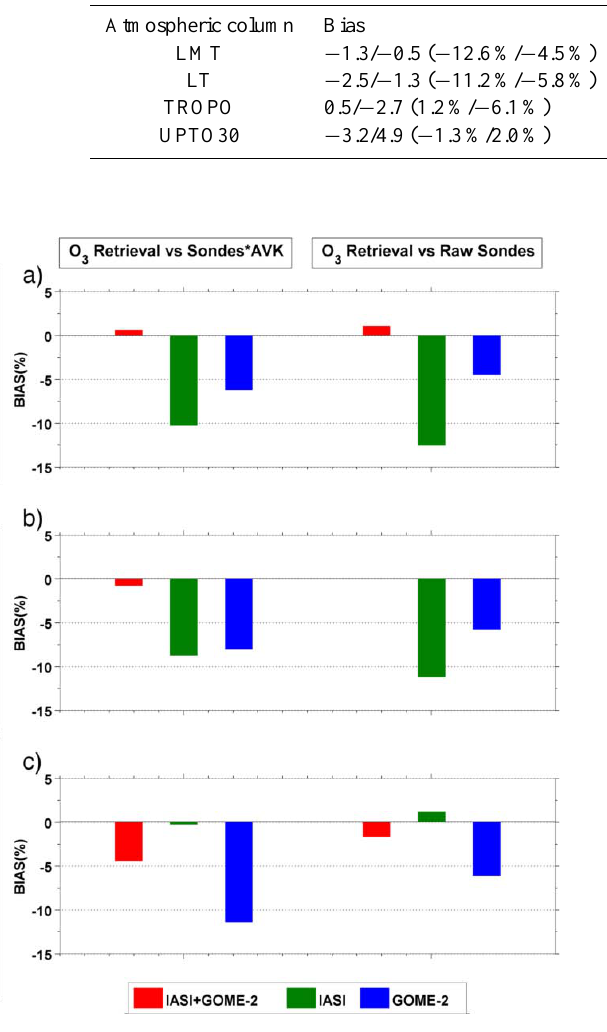
Fig. 7. Mean bias between ozone retrievals from IASI+GOME-2 (red), IASI (green) and GOME-2 (blue) and 105 ozonesondes dur- ing summer 2009 over Europe (smoothed by the retrievals’ AVKs on the left and direct comparisons on the right) for the (a) LMT, (b) LT and (c) TROPO partial